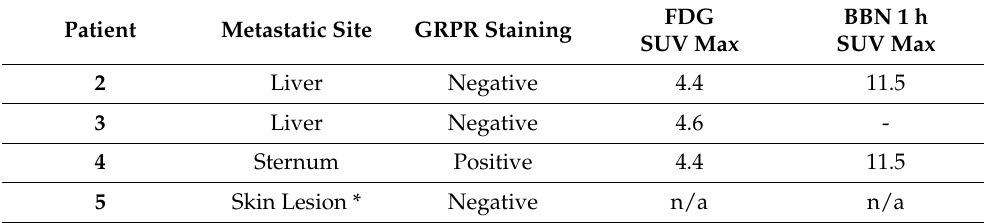
Table 7. GRPR staining of biopsies of metastatic sites.